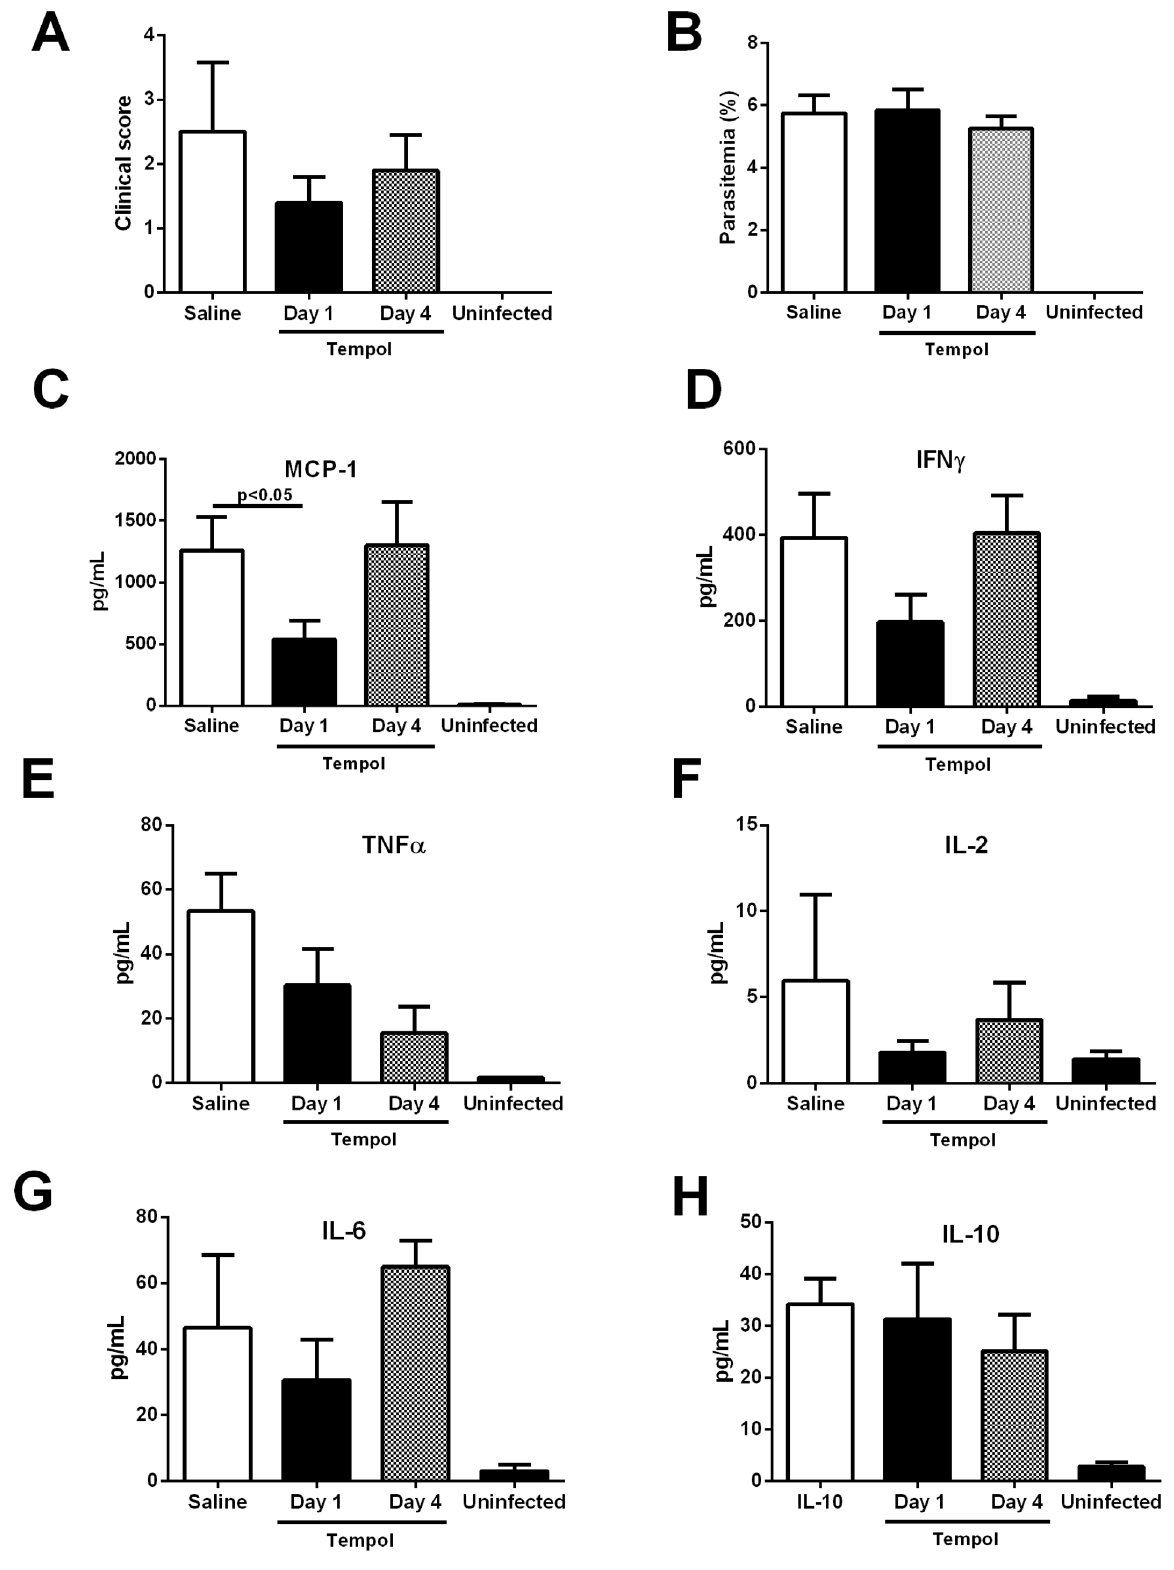
Figure 6. Tempol inhibits MCP-1 plasma levels of mice infected with Plasmodiumberghei Anka. P. berghei Anka parasitized red blood cells (10 6 ) ( n =10) were injected intraperitoneally (i.p.). A, Tempol (20 mg/kg), was started at day 1 or day 4 post infection (p.i.). At day 6 p.i., several parameters were determined including A, clinical score and B, parasitemia (determined by Giemsa-stained smears of tail blood). Serum was collected